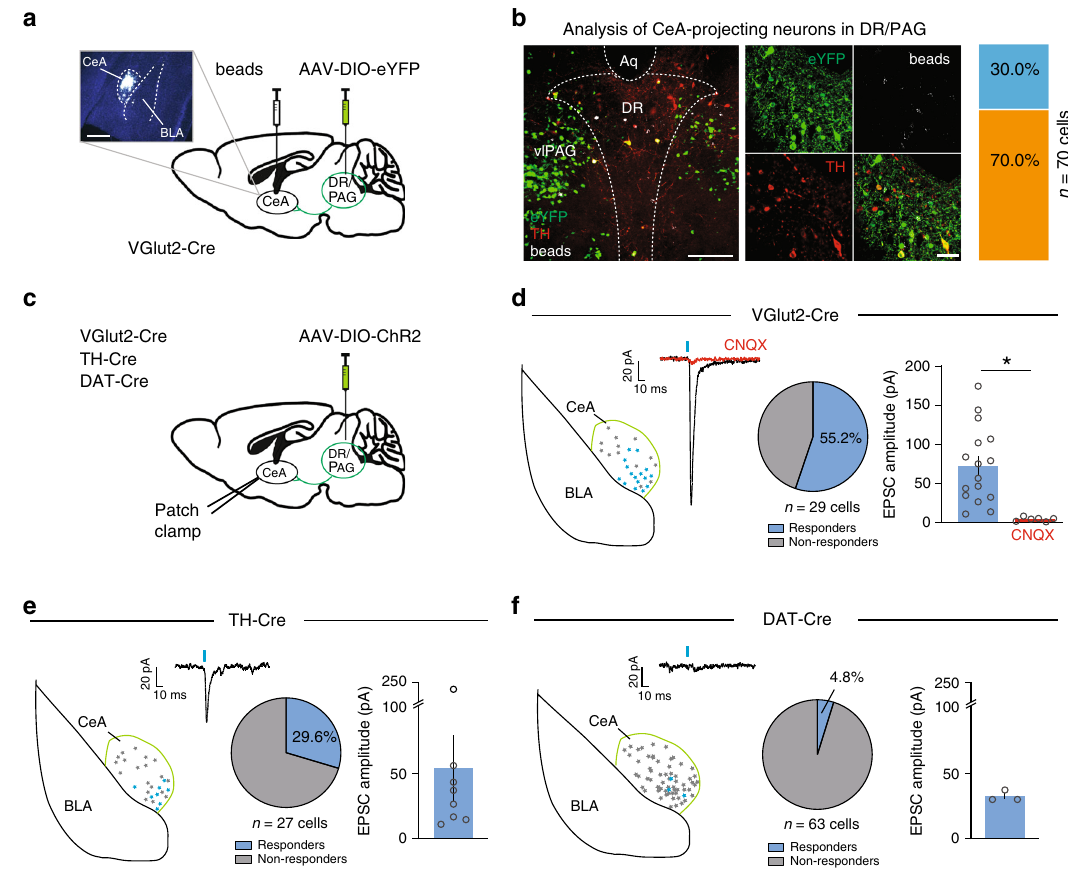
Fig. 6 Optogenetic dissection of the DR/PAG → CeA pathway. a Schematic showing retrograde labeling of central amygdala (CeA) projecting neurons in the dorsal raphe/periaquecductal gray (DR/PAG) using VGlut2-Cre mice. Inset shows sample injection site of retrobeads (white) in the CeA (scale bar 0.5 mm). b Analysis of colocalization between eYFP-positive (i.e., eYFP + , VGlut2 expressing; green) and TH-immunopositive (i.e., TH + , putatively dopaminergic; red) CeA-projecting (i.e., beads + , white) cell populations in the DR/PAG. Left: Confocal image showing overview of DR/PAG in VGlut2-Cre mice (scale bars 0.5 mm). Middle: Higher magni fi cation image. Right: Slice charts showing percentage of beads + and eYFP + cells that co-express TH (eYFP + /beads + /TH + , blue) or lack expression of TH (beads + /eYFP + /TH − , orange) in the DR/PAG (scale bars 50 µ m). c Schematic of experimental design to analyze functional connectivity of DR/PAG inputs to CeA neurons using DAT-Cre, TH-Cre and VGlut2-Cre mice. d Sample traces from whole- cell recordings at − 70 mV showing EPSCs generated by light stimulation of DR/PAG VGLUT2 inputs to CeA neurons (red trace: sample of mean EPSC after CNQX application; scale bars: 20 pA/10 ms). Schematics shows localization of the recorded neurons in the CeA that responded (blue) and did not respond (gray) to light stimulation. Pie chart shows percentage of responders (blue) and non-responders (gray). Bar graph showing mean EPSC amplitudes for the cells that responded to light stimulation before (blue) and after (red) bath application of 10 μ M CNQX (paired t -test, t (5) = 3.835 p = 0.0122, n = 6 cells; * p < 0.05; error bars represent SEM). e , f Same as in d , but experiments were performed in TH-Cre ( e ) and DAT-Cre ( f ) mice. Data provided as a